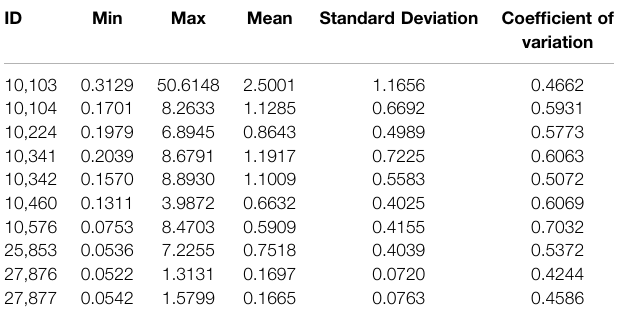
TABLE 1 | Descriptive statistics of the considered 10 time series of SSC. ID